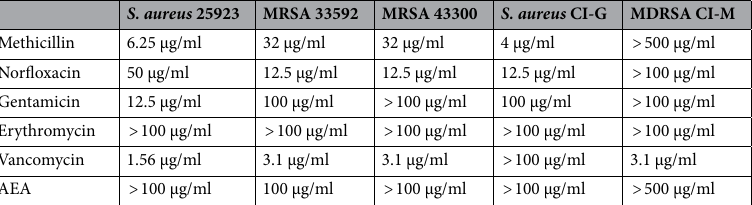
Table 1. The MIC of MDRSA CI-M to various antibiotics and AEA in comparison to other S. aureus strains. MIC Minimum inhibitory concentration that leads to invisible bacterial